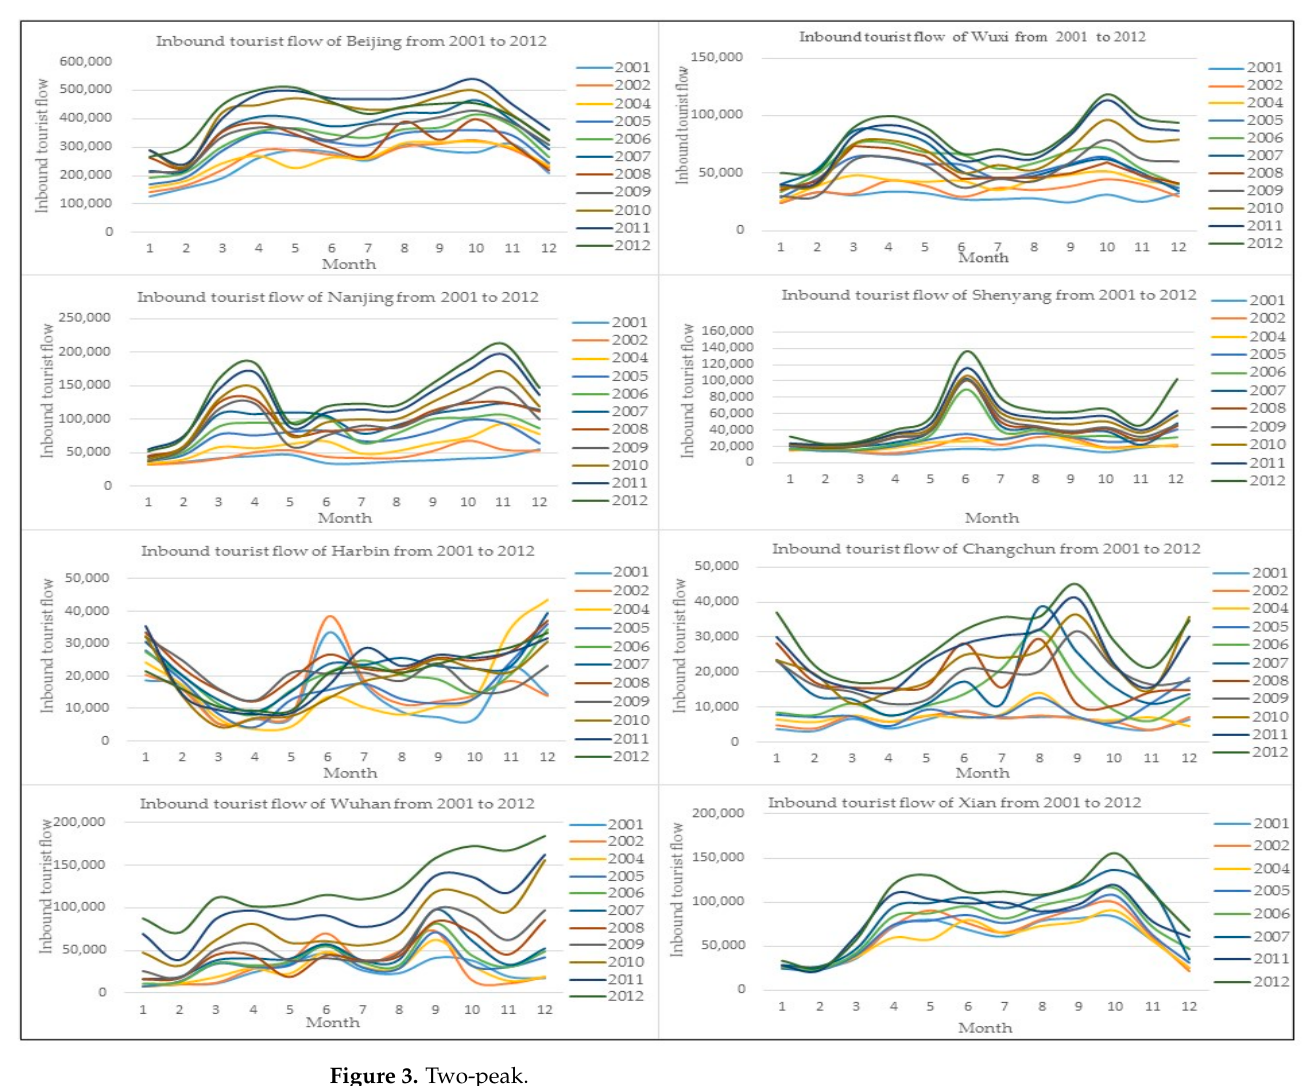
Figure 3. Two-peak. Figure 3. Two-peak.